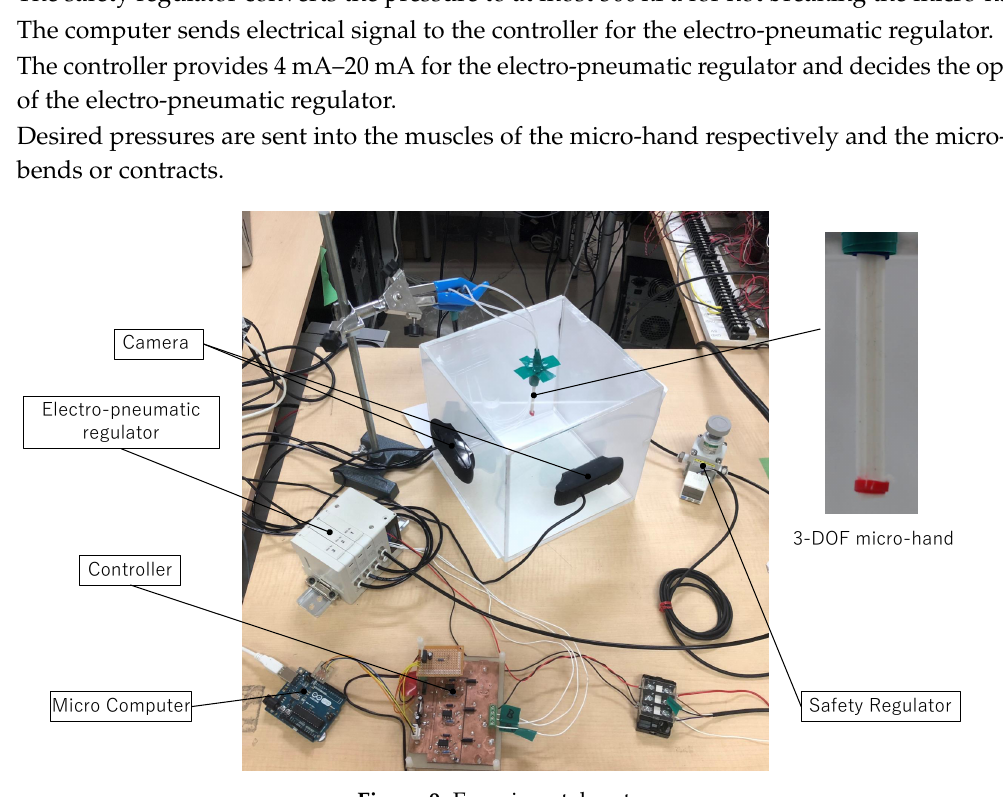
Figure 9. Experimental